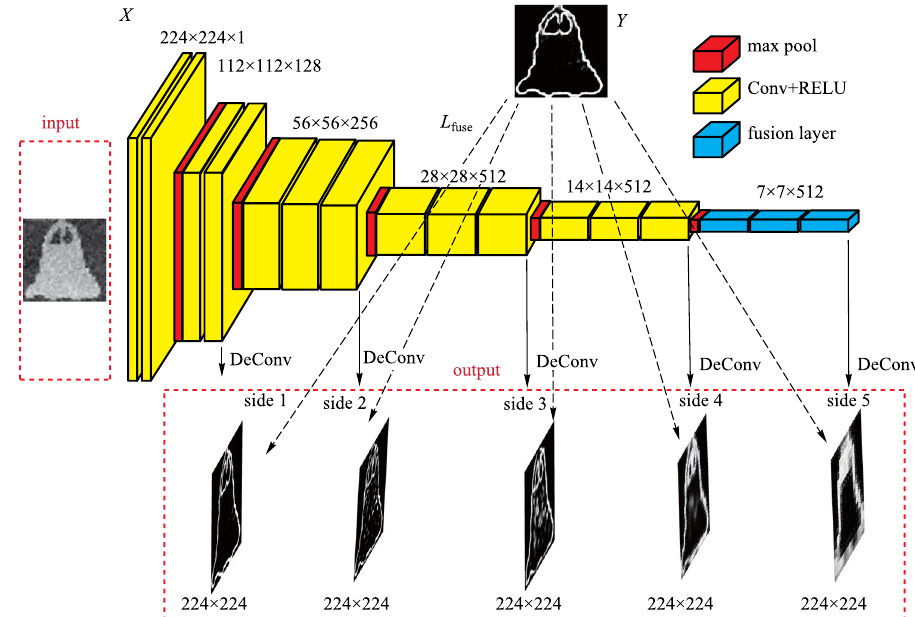
Fig. 2 Structure of the holistically-nested edge detection